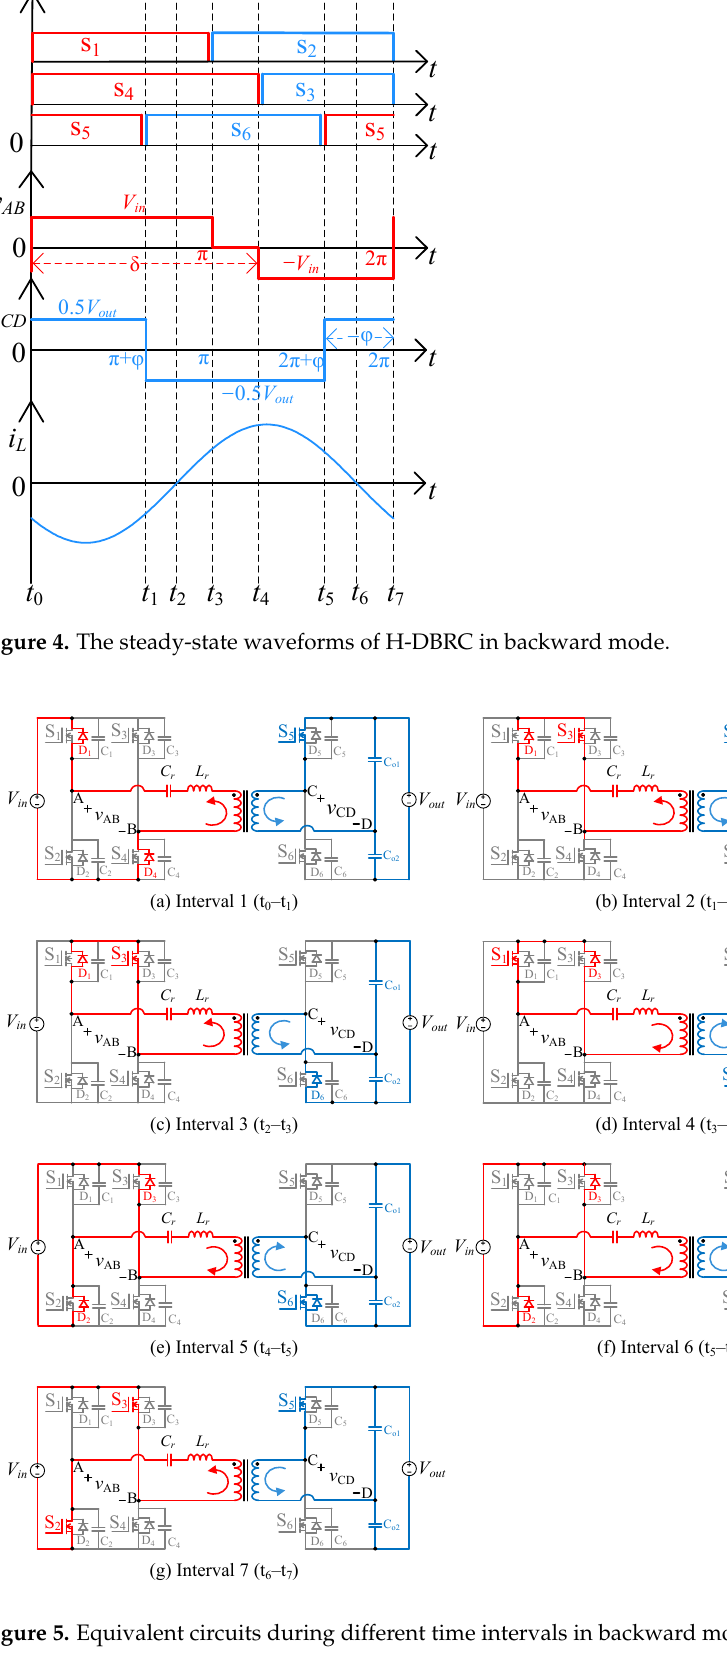
Figure 5. Equivalent circuits during different time intervals in backward